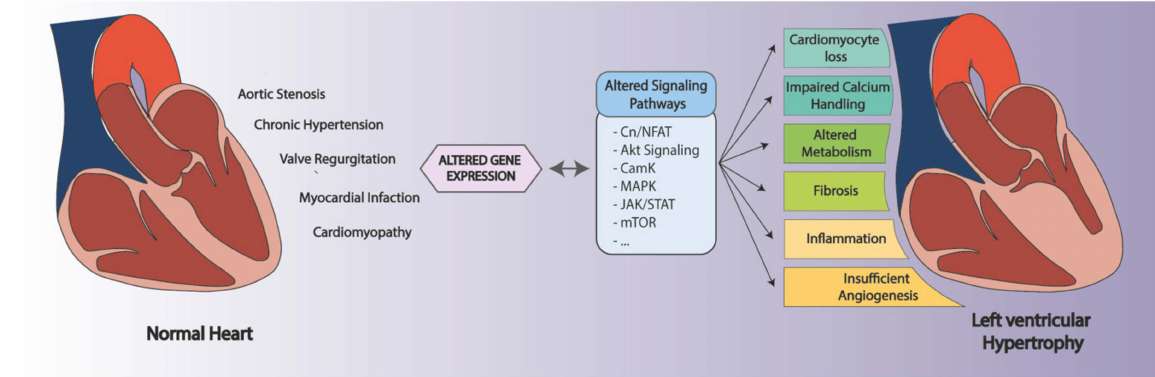
Figure 1. Schematic representation of the mechanisms involved in the development of pathological left ventricular